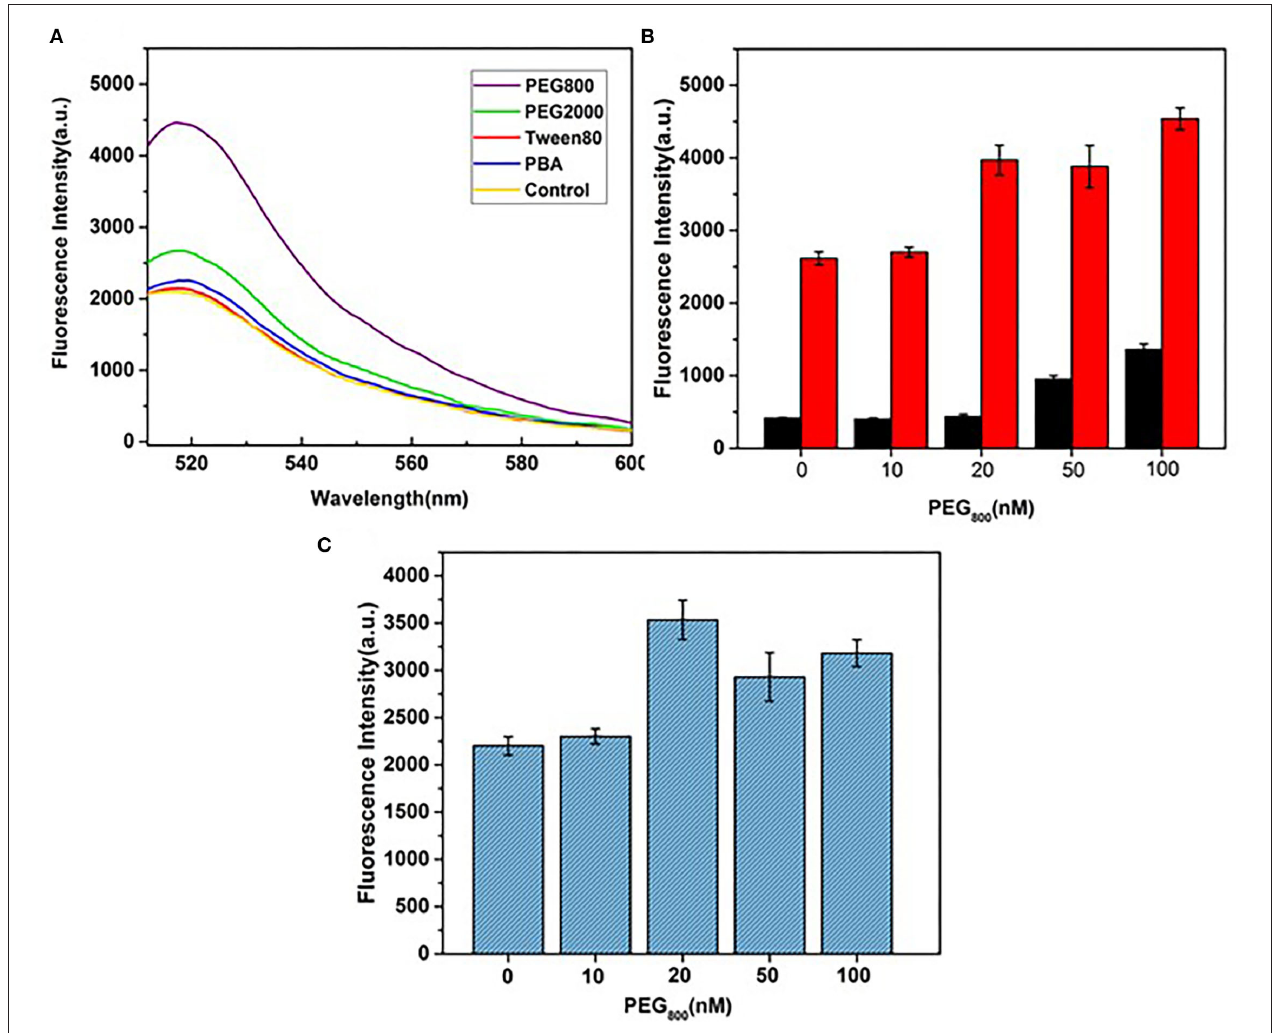
FIGURE 3 | Selection and optimization of blocking agents. (A) Fluorescence recovery effects of different types of blocking agents. (B) Effects of PEG800 concentration on fluorescence quenching (black bar) without HA and fluorescence recovery (red bar) with HA. (C) Effects of PEG800 concentration on fluorescence signals.